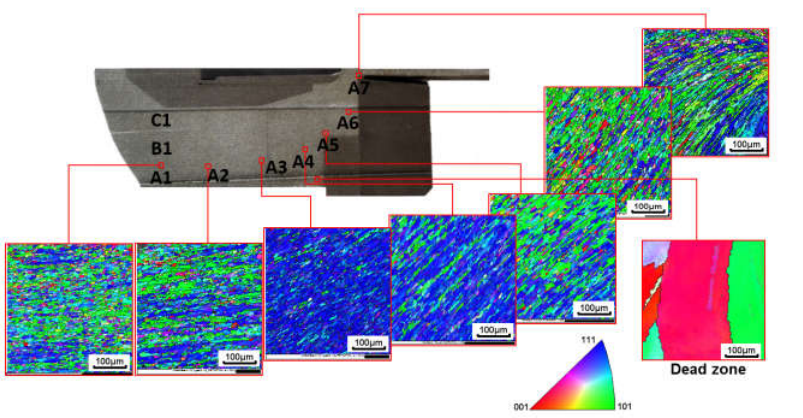
Figure 6. Microstructure evolution in the longitudinal section along the flow line A characterized by EBSD.